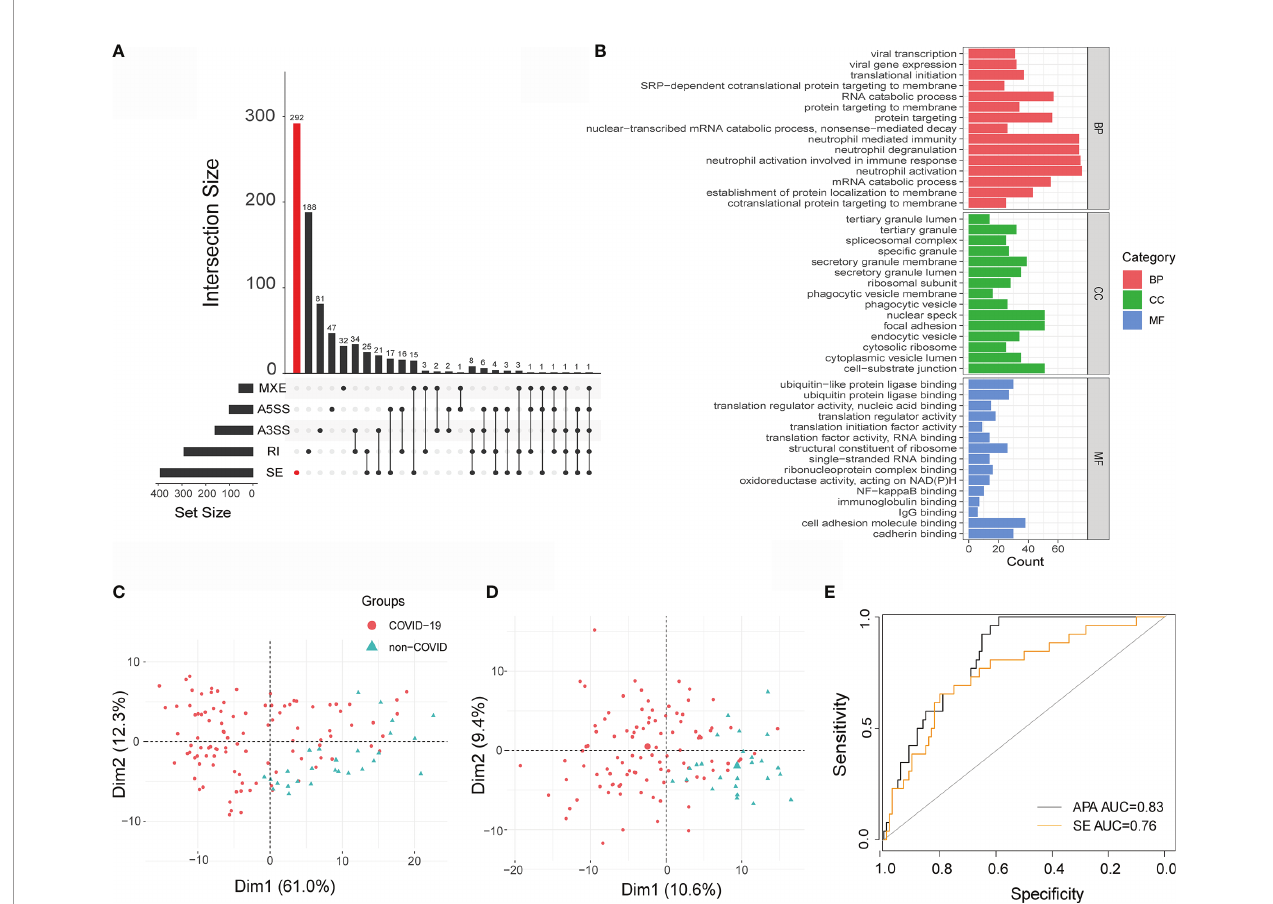
FIGURE 6 | Performance of APA and SE analysis. (A) Bar plot showing the genes exhibiting AS during SARS-CoV-2 infection (at 5% FDR). (B) GO terms obtained from functional annotation analysis using R software. (C) Principal component analysis (PCA) of APA and SE (D) . Each dot represents one sample. Red: COVID-19, Green: non-COVID-19. (E) Receiver operating curve (ROC) plot of the performance based on accuracy using PC1 for APA and